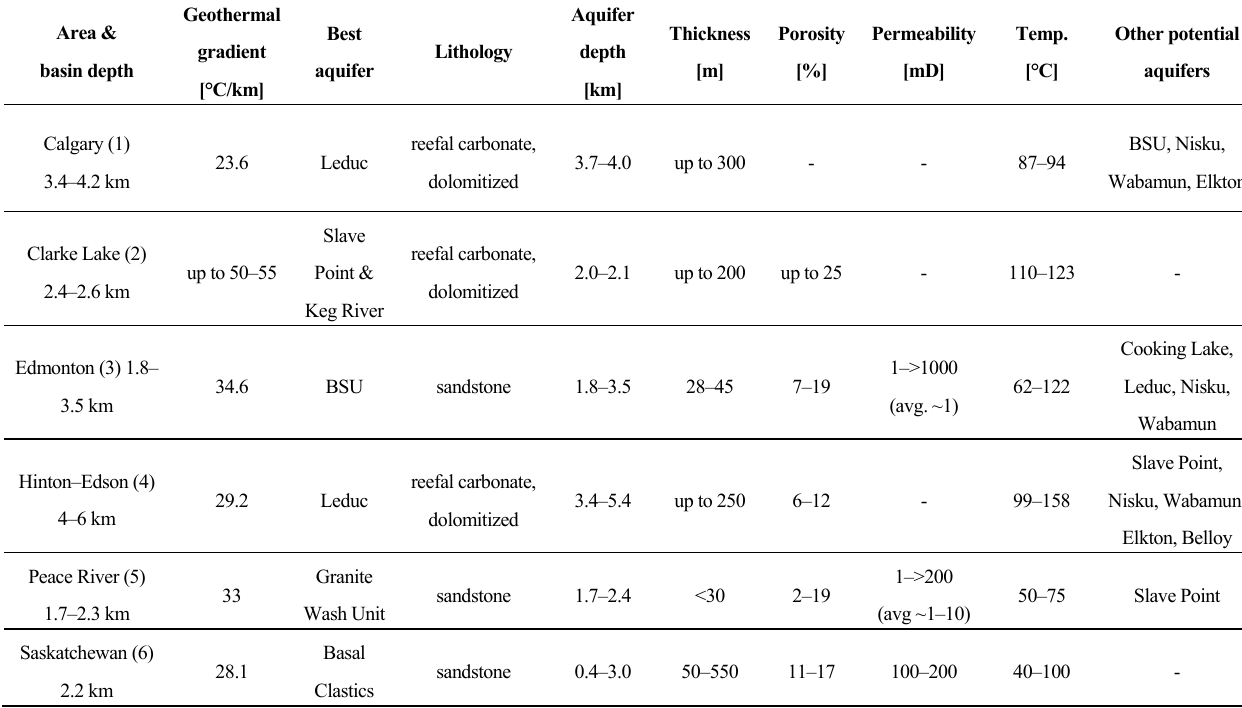
Table 2. Results from previous regional geothermal studies in the WCSB; See Figure 4